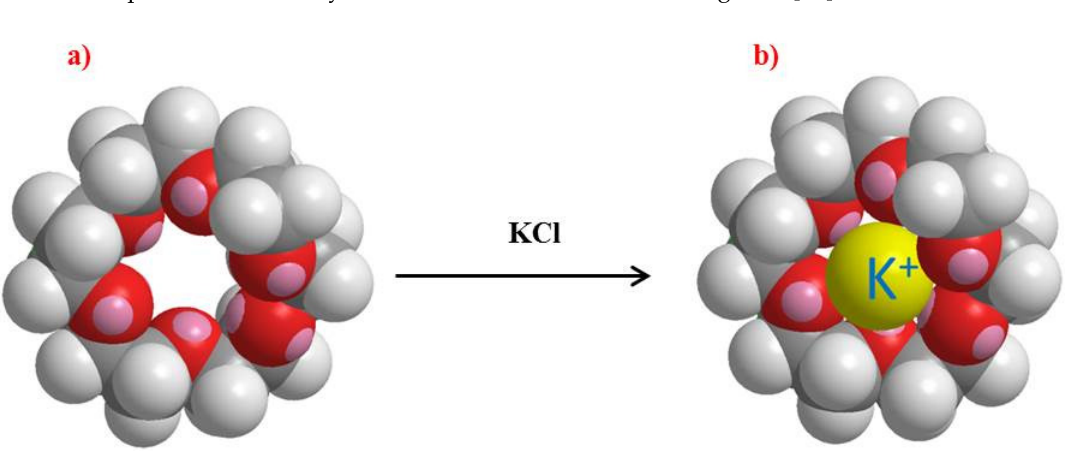
Figure 3. Experimental set-up for recording of the SRG